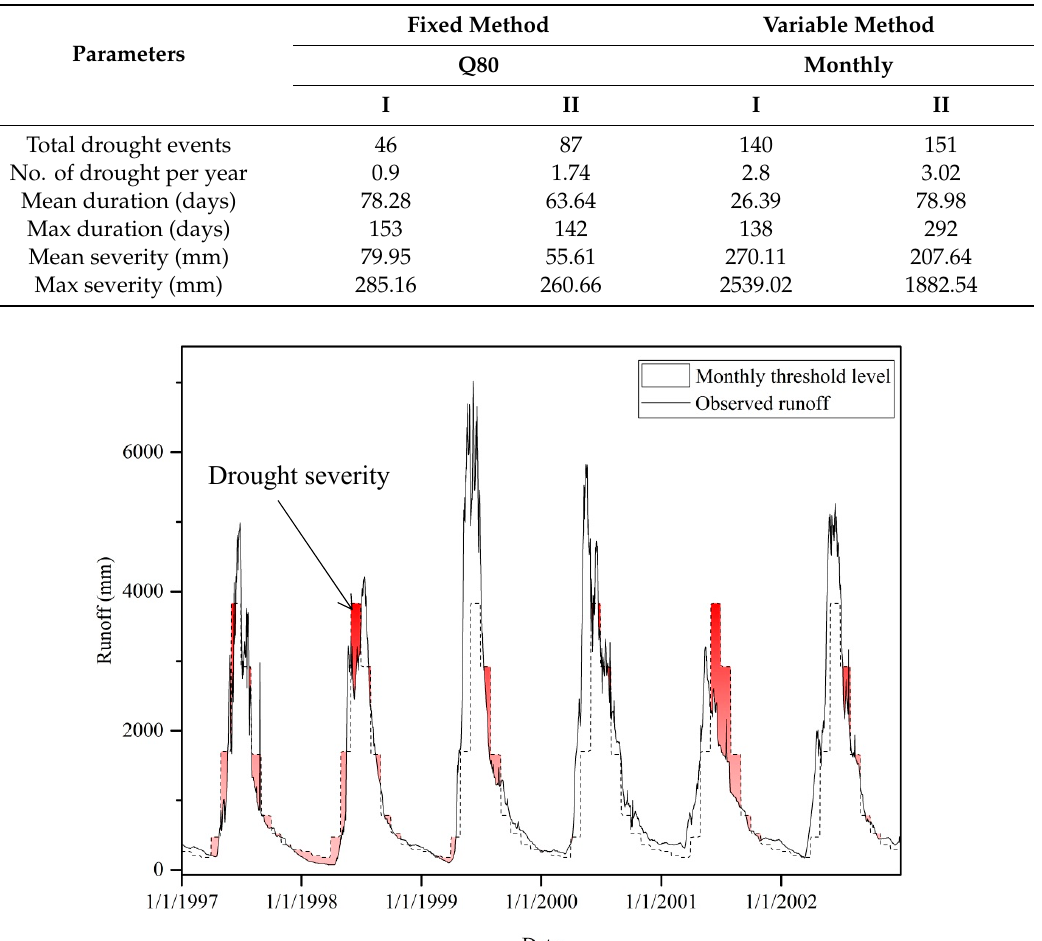
Figure 25. Example of drought analysis based on transient threshold levels for the Zone I.